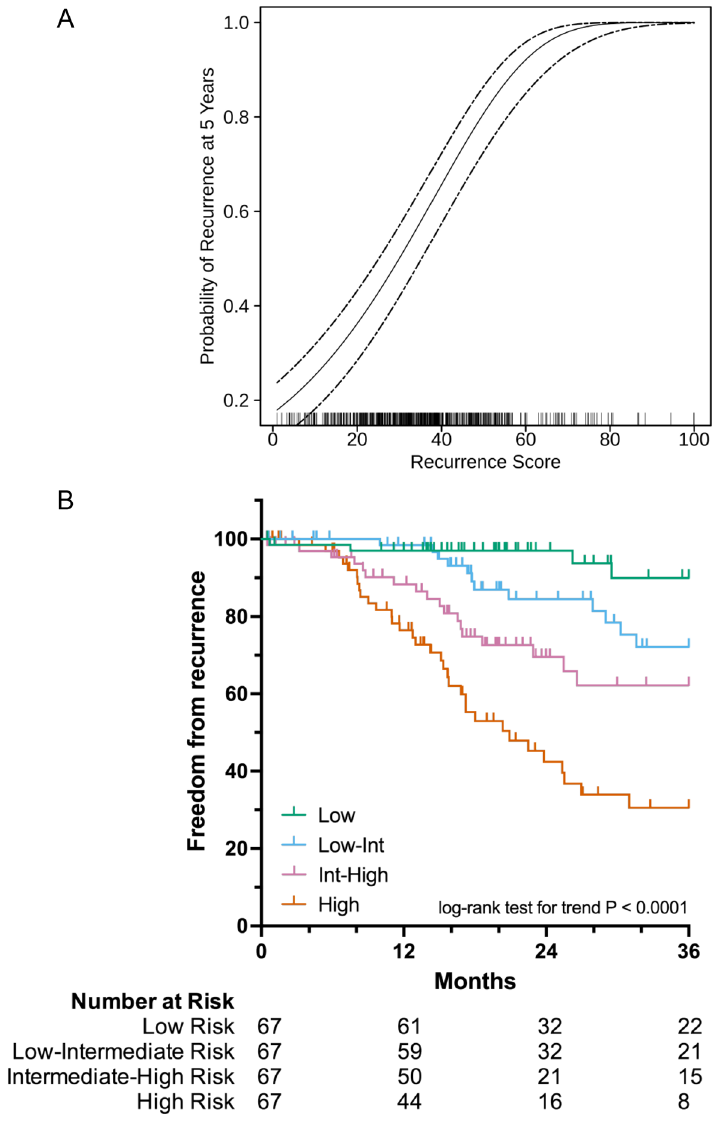
Figure 1. Recurrence score is prognostic of recurrence in the TCGA lung adenocarcinoma cohort. Recurrence score is directly proportional to probability of recurrence at 5 years within the entire TCGA lung adenocarcinoma cohort ( A ) and is prognostic of recurrence when stage I patients are divided into cohorts by recurrence score quartile ( B ).